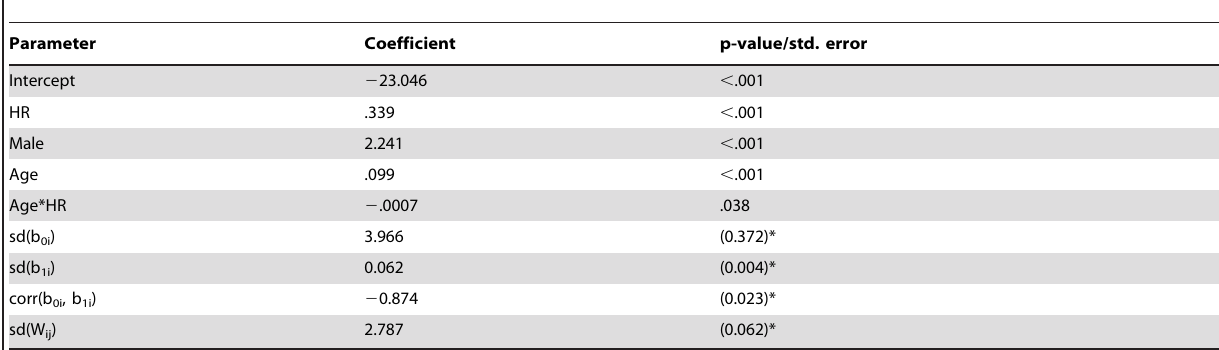
representative age-sex categories. Note that age stratification of Table 3. Model 2 Group Equation Parameter